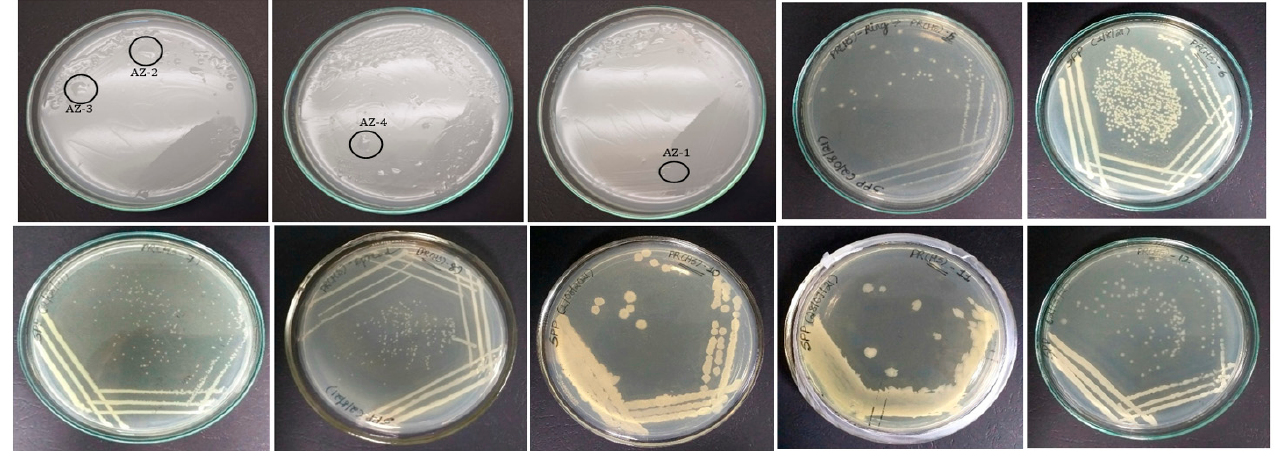
Figure 1. Pure colony of bacteria isolated on Ashby agar plates (AZ-1, 2, 3 and 4), and nutrient agar plates (PR-HS-5, 6, 7, 8, 10, 11 and 12).